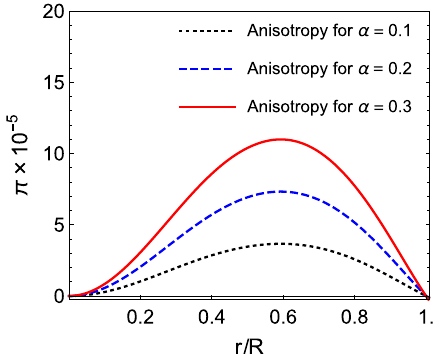
Fig. 2 The dependence of anisotropy with dimensionless radius ( r / R ) for different values of coupling constant( α ) are shown. The pictures are drawn for M 0 = 1 and R = 5